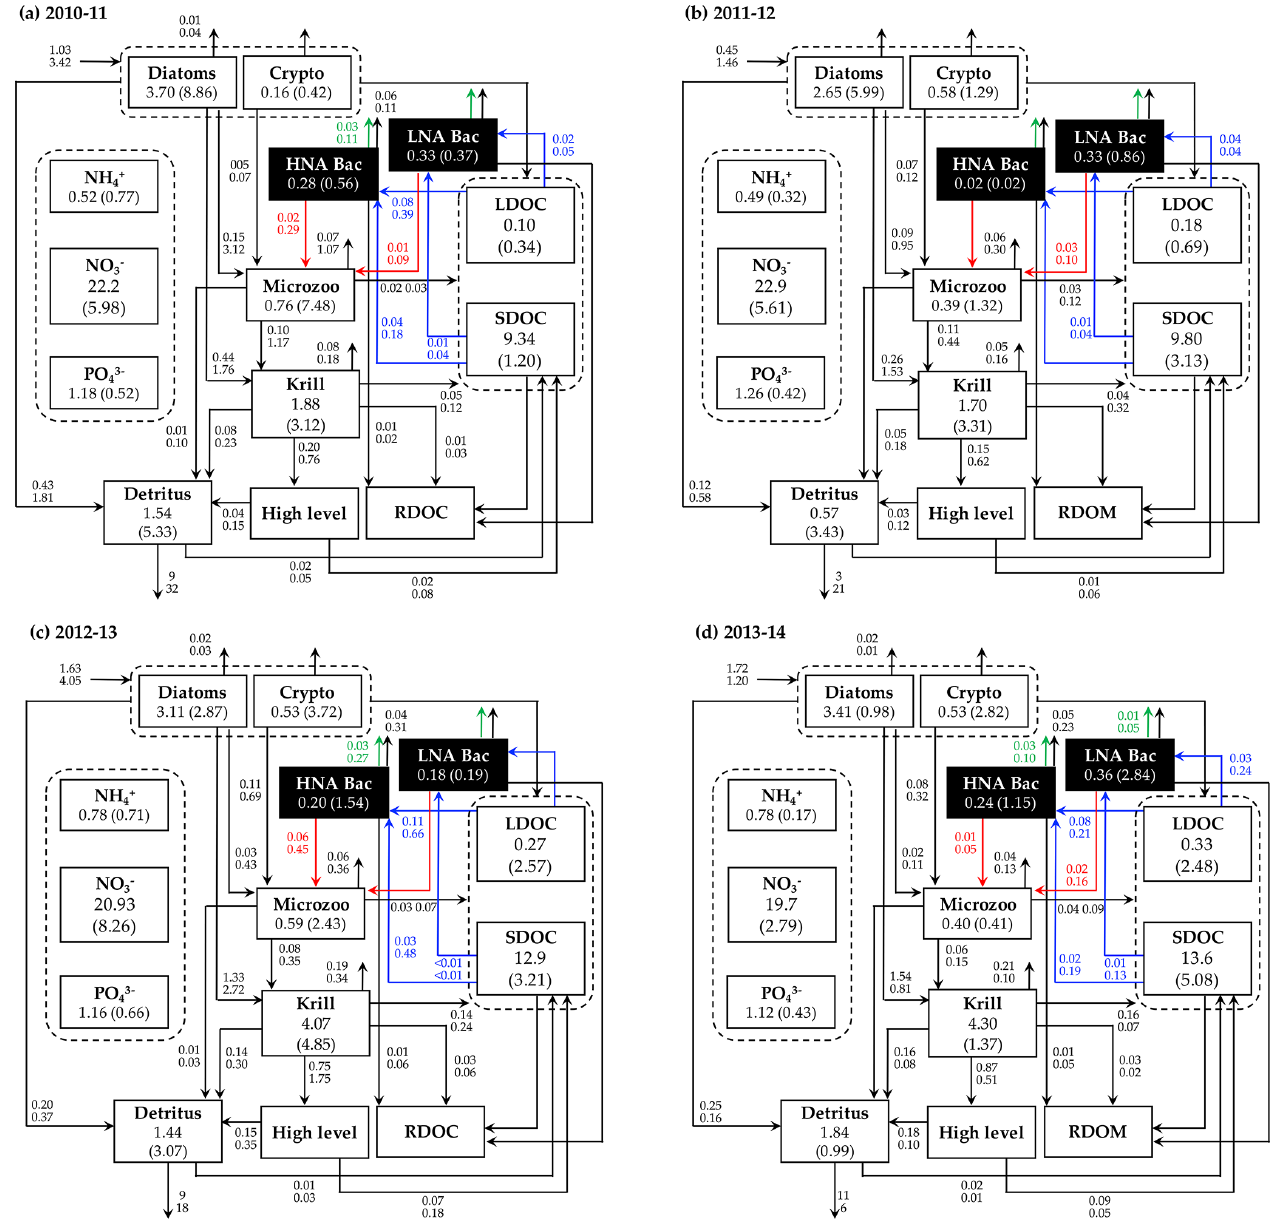
Figure 5. Annual mean carbon stocks and flows. Carbon stocks (mmolCm − 3 ) and flows (mmolCm − 3 d − 1 ), particle sinking flux (mmolCm − 2 d − 1 ), and other stocks (e.g., nutrients, mmolm − 3 ) averaged over the growth season in each year are denoted as the num- bers on the first row, while the numbers in the second row or in the parentheses are the standard deviation propagated from averaging over the growth season and the Monte-Carlo-derived uncertainties. Numbers around the arrows represent intercompartmental flows and do not necessarily balance to zero due to the build-up or loss in a compartment over the growth season. The magnitude of the N and P flows, as well as the flows smaller than 0.01mmolCm − 3 d − 1 , are omitted. RDOC and higher levels are implicit.